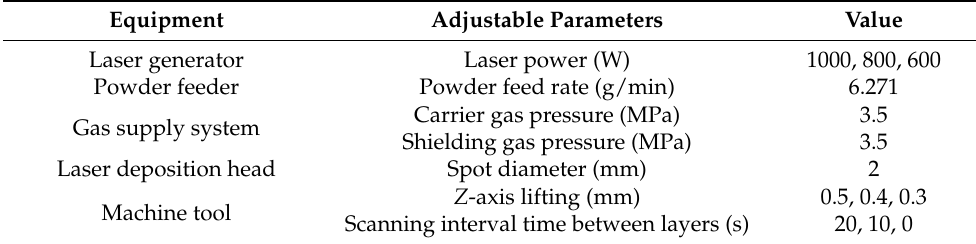
Table 2. Laser cladding test parameters and values.